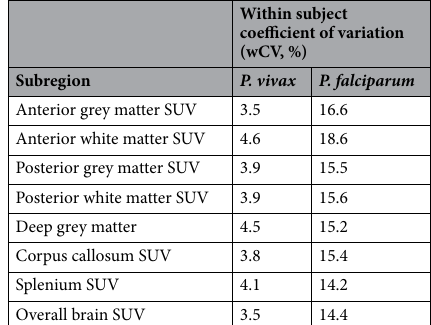
Table 2. Within subject coefficient of variation (wCV) for radiotracer uptake in each subregion of the brain and overall brain in P.vivax and P. falciparum groups. SUV standardized uptake